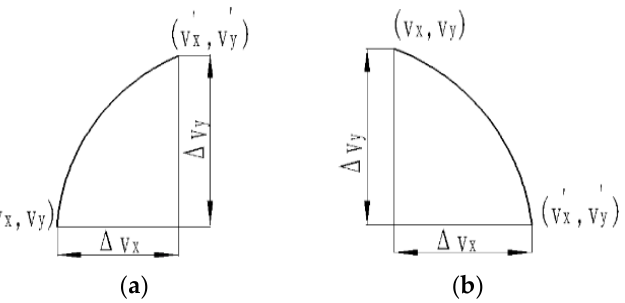
Figure 17. Speed trend for link_1. ( a ) Change in upstream speed, ( b ) downstream speed variation. Figure 16. Velocity of link_1 in the y direction vs. time. ∇(cid:3049) (cid:3300) After analysis, the maximum value of was 93.65, corresponding to a velocity ∇(cid:3049) (cid:3299) difference of 30.2 mm/s in the x-direction and 2.83 × 10 3 mm/s in the y-direction. The min- ∇(cid:3049) (cid:3300) was 0.15, corresponding to a velocity difference of − 1.48 × 10 3 mm/s in imum value of ∇(cid:3049) (cid:3299) the x-direction and − 2.25 × 10 2 mm/s in the y-direction; the positive and negative values ∇(cid:3049) (cid:3300) cross. This shows that the chain drive film-soil separation mechanism is useful for of ∇(cid:3049) (cid:3299)